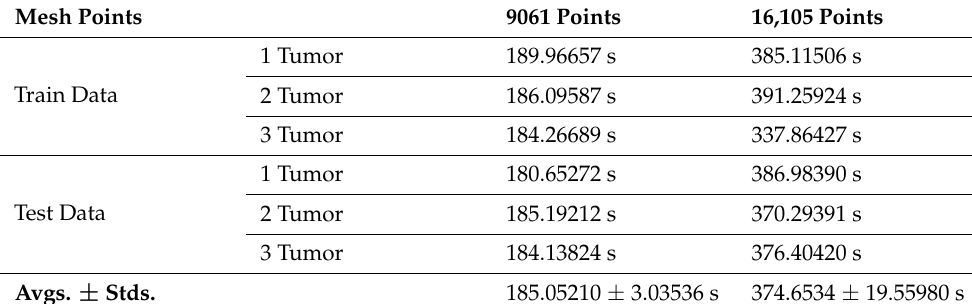
Table 7. Image generation time with the MP-based